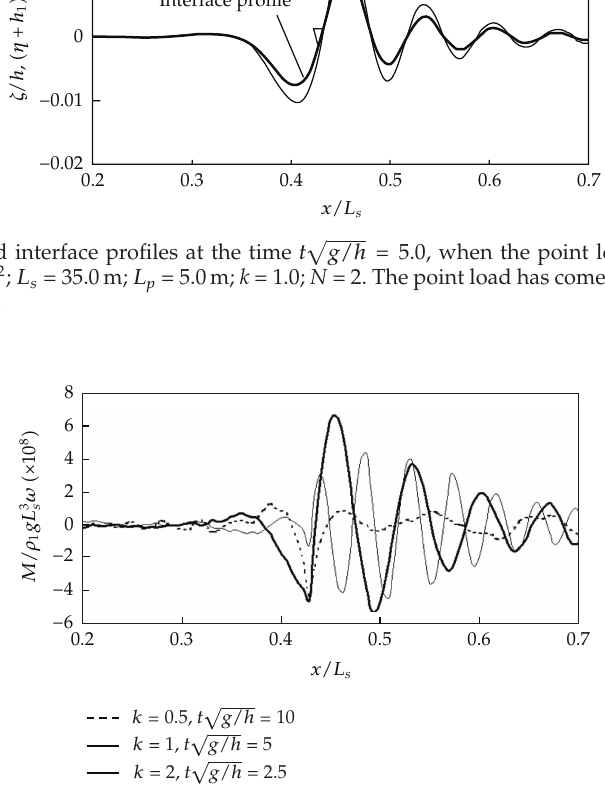
Figure 10: Distribution of bending moment M of the floating thin plate at the time when the point load stops movement, where B s (cid:7) 500.0Nm 2 ; L s (cid:7) 35.0m; L p (cid:7) 5.0m; k (cid:7) 0.5, 1.0, and 2.0; N (cid:7) 2; unit width ω (cid:7)